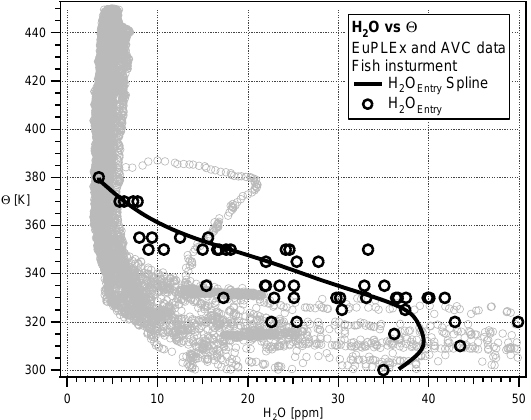
Fig. 6. H 2 O data plotted versus the potential temperature. Small grey circles show FISH data during the EuPLEx/AVC campaigns, large black circles mark the H 2 O entry values given by Krebsbach (2005) and the black line denotes the H 2 O entry fit, H 2 O entry (θ) , used to derive tropospheric boundary